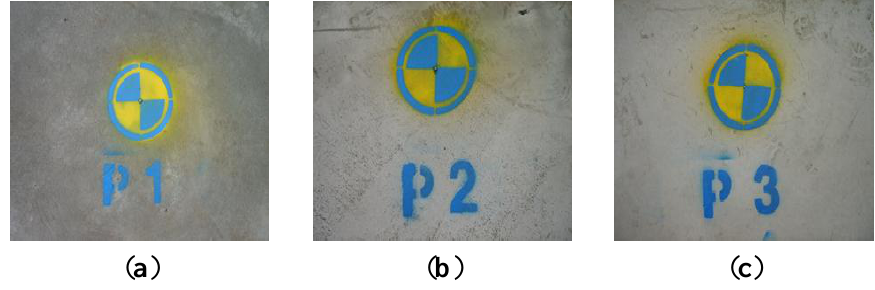
Figure 11. Prism: ( a ) point 1 mark, ( b ) point 2 mark, and ( c ) point 3 mark.